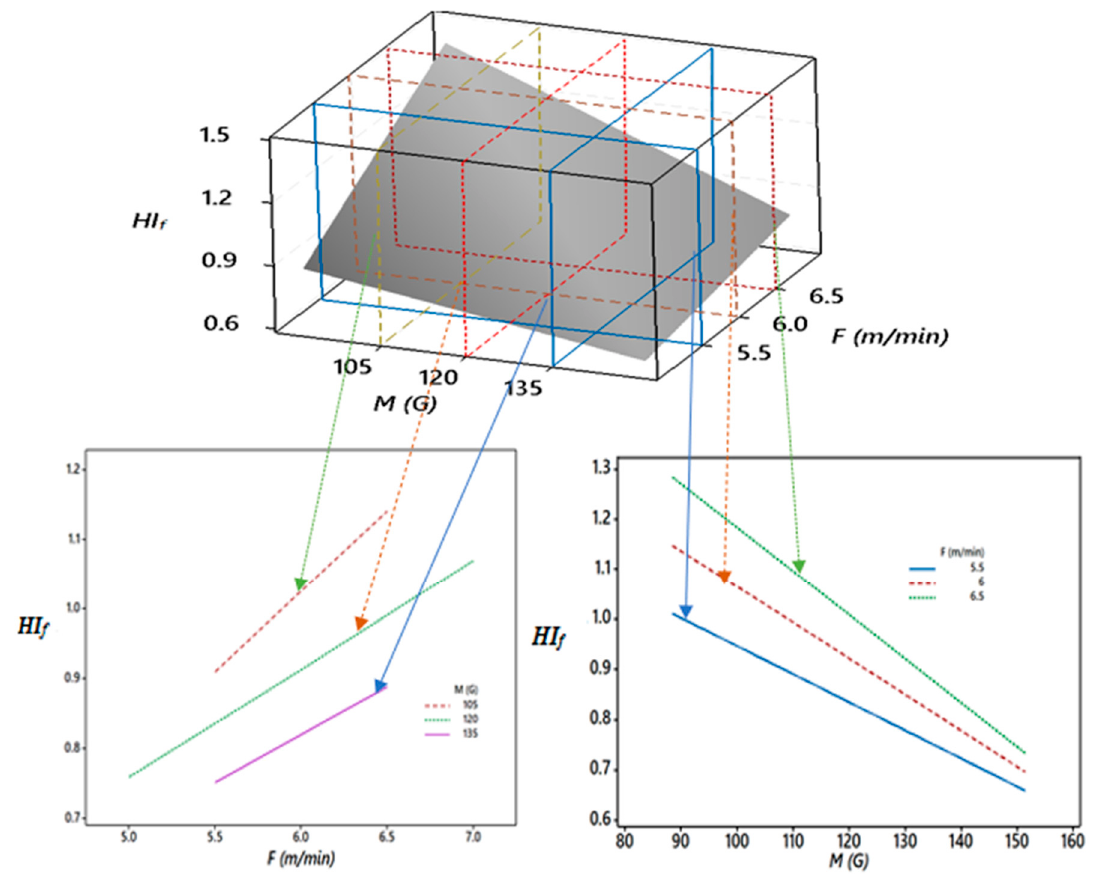
Figure 9. Sectioned 3D and 2D plots for the interaction effects of M and F on HI f .